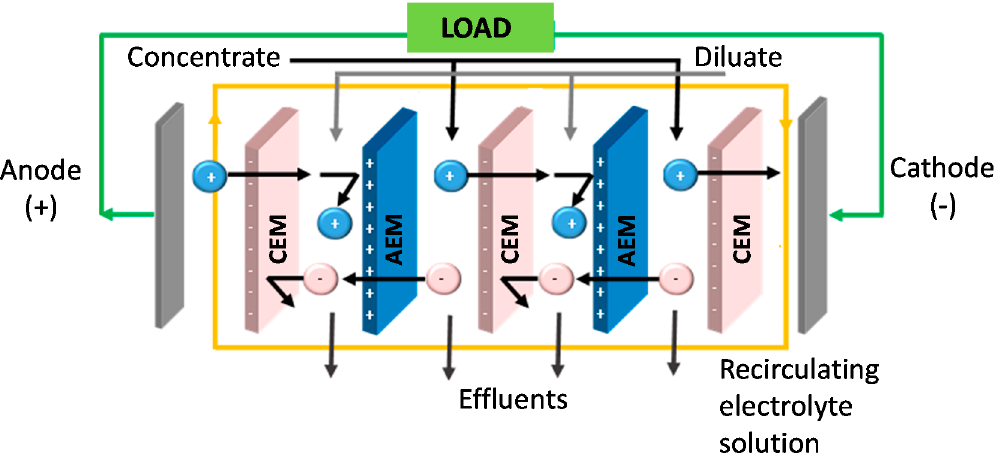
Figure 1. Illustration of the RED process.